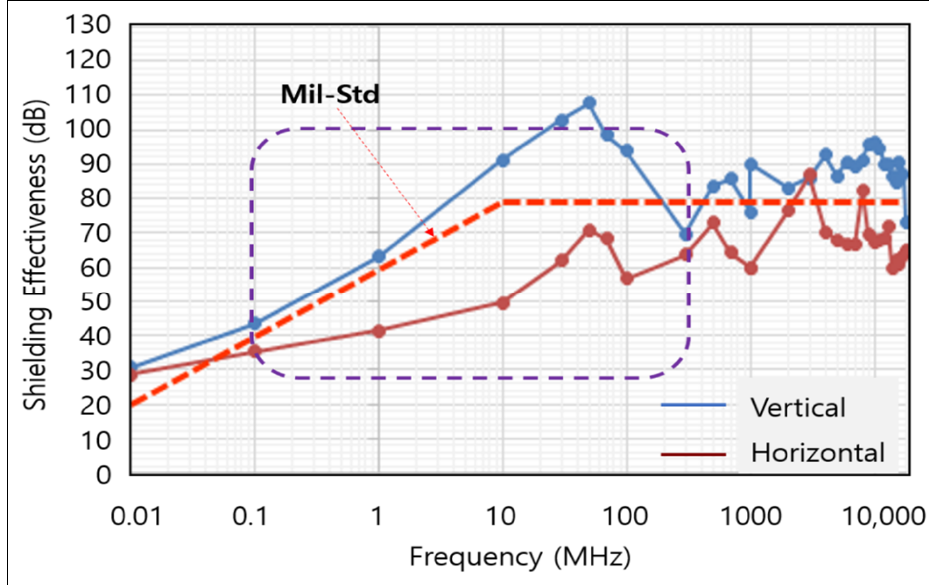
Figure 5. Shielding effectiveness of specimen #2 (W = 20).